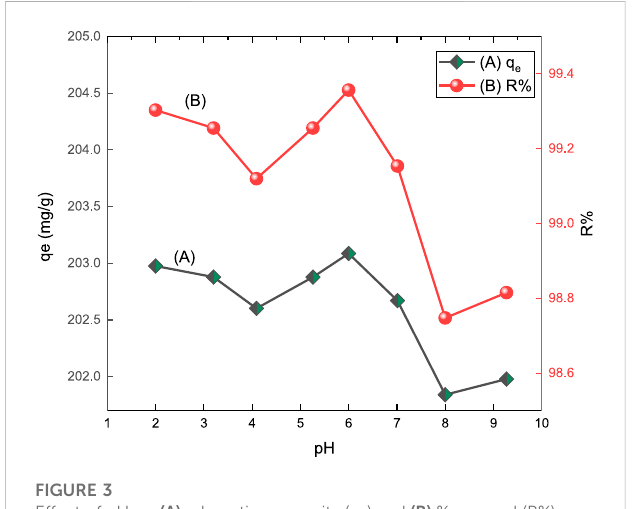
FIGURE 4 Effect of contact time on (A) adsorption capacity (q t ) and (B) % removal(R%)ofacidred37dyeonCM- β CD:nChi:Glu(25 mgofadsorbent